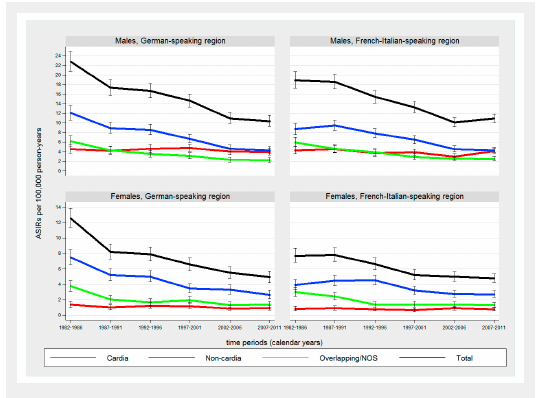
Figure 3 Time trends in age-standardised incidence rates (ASIRs) (European standard population) of gastric cancer by sex, anatomical location and language region from 1982 to 2011. NOS = not otherwise specified